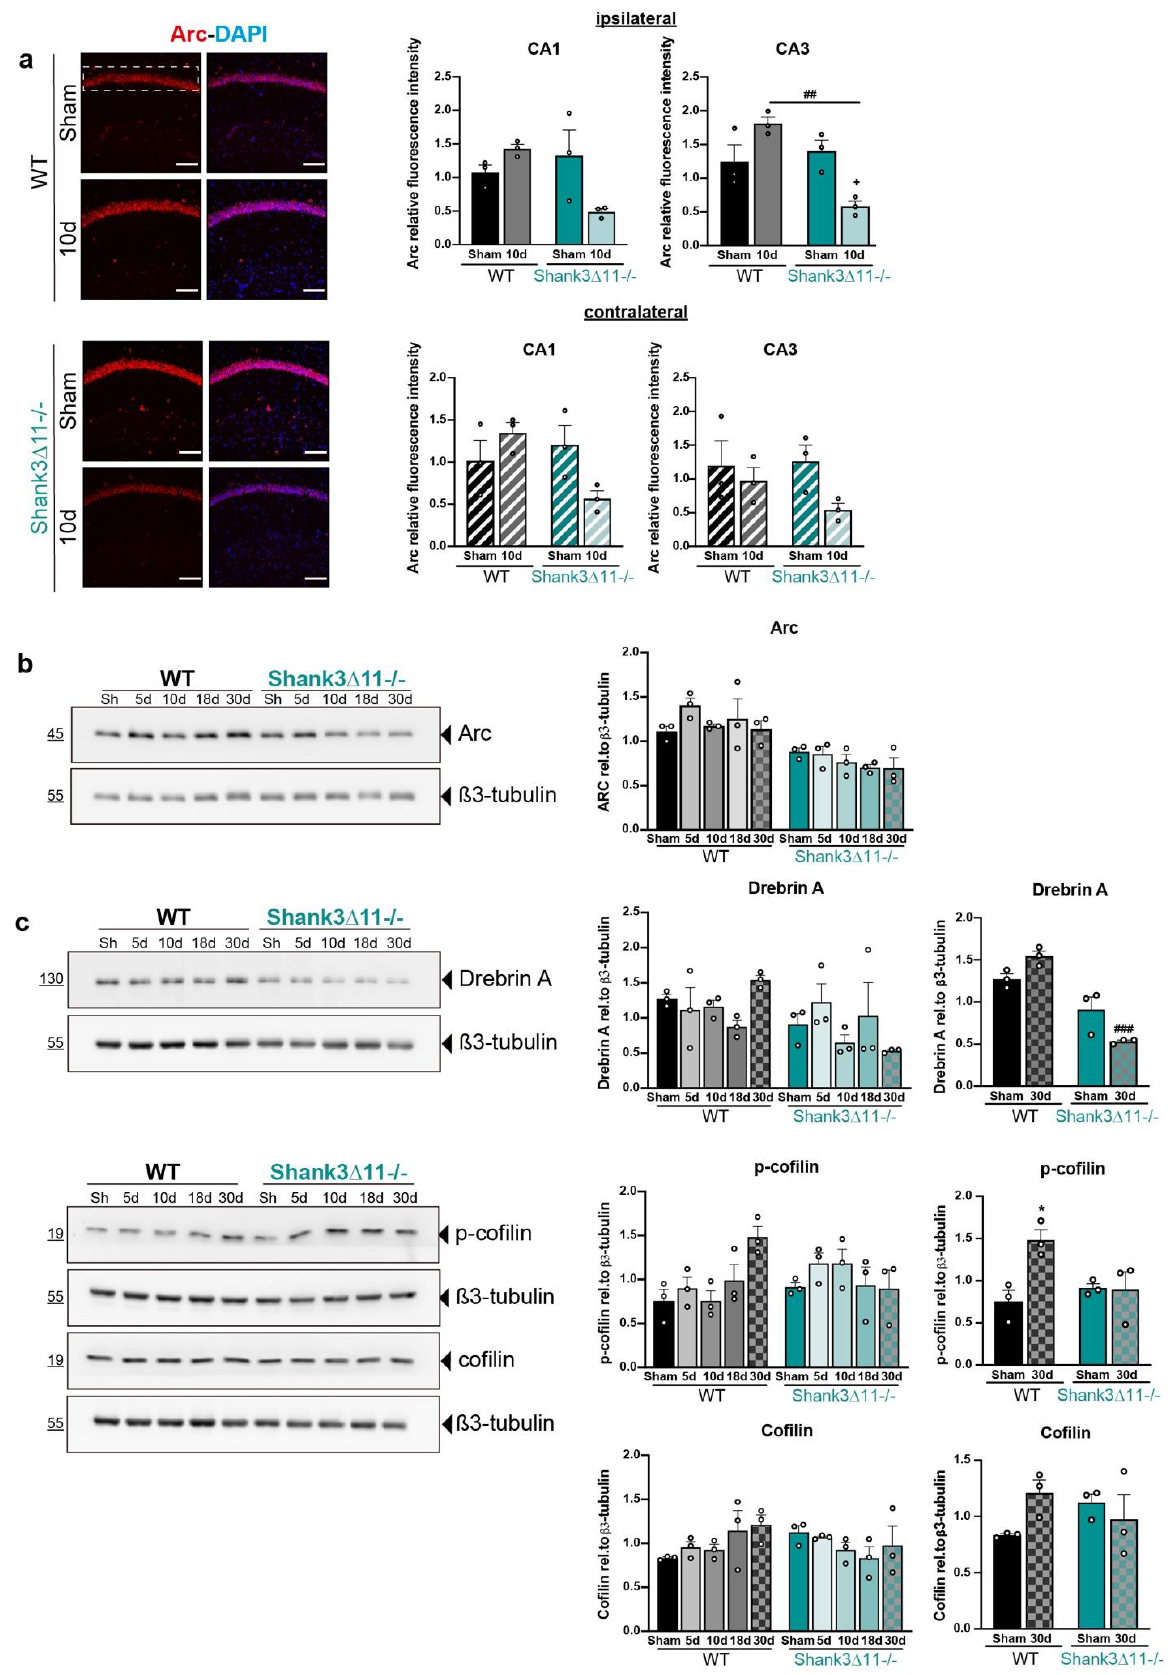
Figure 5. Expression of synaptic and structural plasticity proteins are mainly affected in Shank3 ∆ 11 − / − animals after mTBI. ( a ) Immunostaining for Arc protein after 10d of mTBI (left panel).